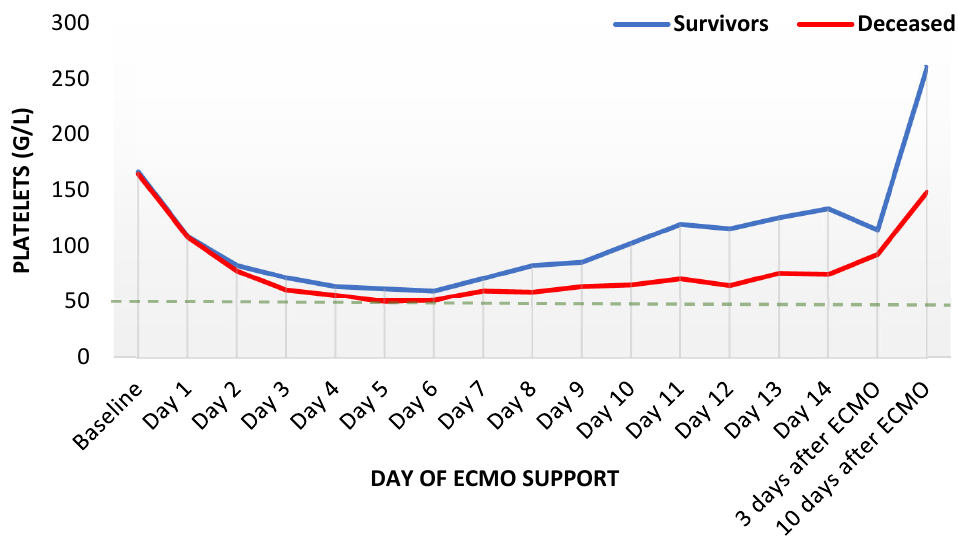
Figure 4. Trends of platelet count during ECMO support, presented as median values ( n = 435). ECMO: extracorporeal membrane oxygenation.